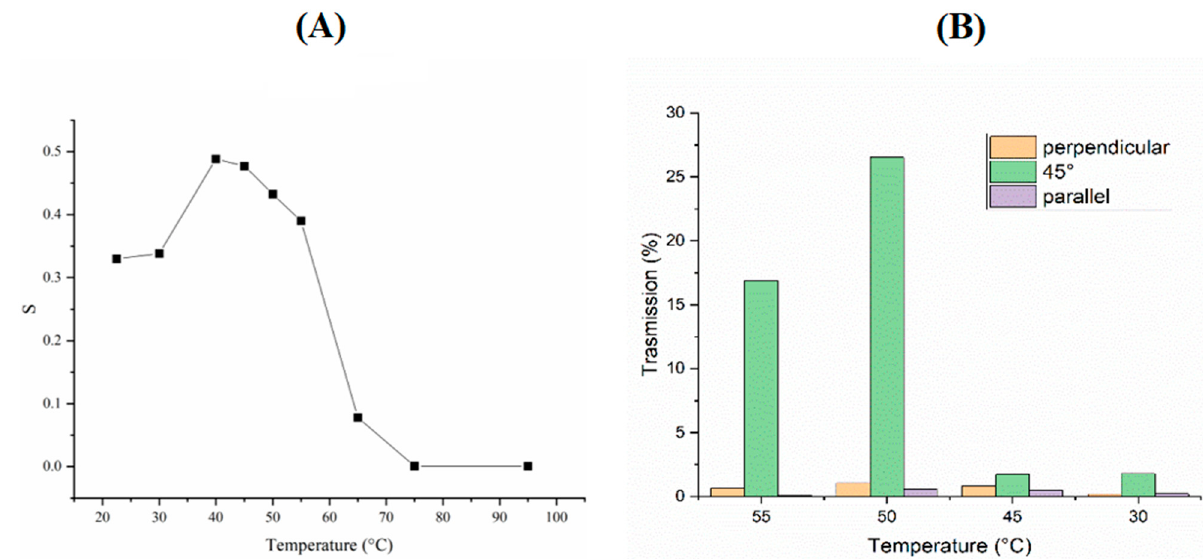
Figure 2. Order parameter experiment. ( A ) S calculated from transmission measurements vs. temperature with laser wavelength at 457 nm. ( B ) Transmitted light vs. temperature and for different orientations of light polarization with respect to the direction 𝐧 (laser wavelength at 633 nm).